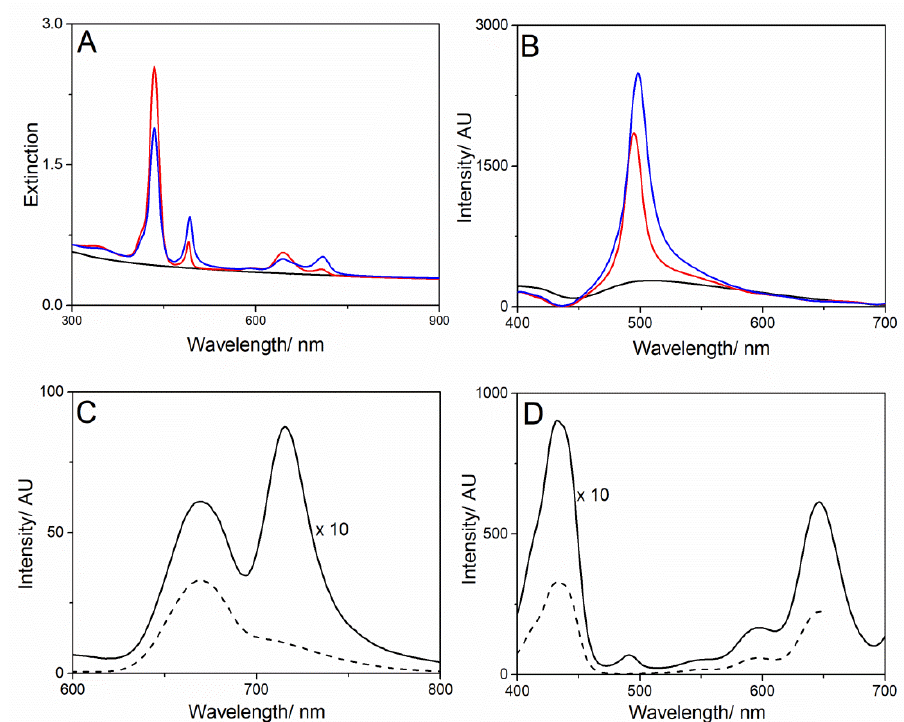
Figure 9. UV- Vis spectra ( A ) and RLS ( B ) of MWCNT-EPA (black line), upon TPPS addition (red line) and 4 h after mixing (blue line); ( C ) Fluorescence emission spectra of MWCNT-EPA / TPPS J-aggregates (dashed and solid lines at λ exc = 455 and 492 nm, respectively) and ( D ) the corresponding excitation spectrum ( dashed and solid lines at λ em = 669 and and 717 nm, respectively). Experimental conditions: [TPPS] = 5 µ M; MWCNT-EPA = 0.02 mg / mL; 10 mM citrate bu ff er at pH 2.4; [NaCl] = 0.15 M, PL protocol; T = 298 K.